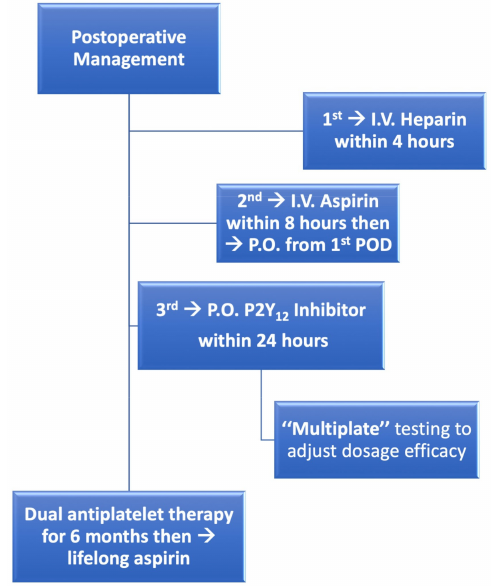
Figure 2. Postoperative management regime for patients undergoing coronary endarterectomy.